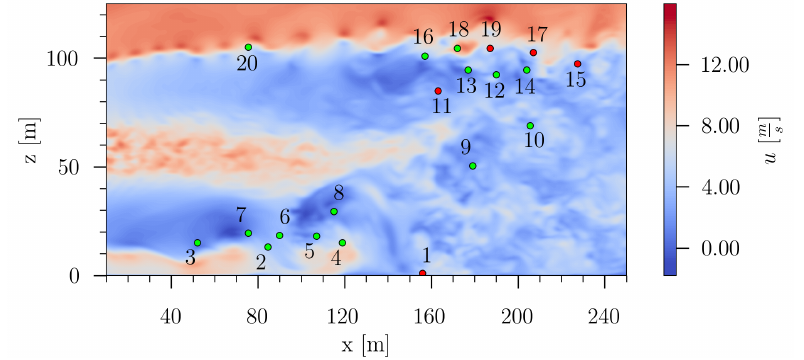
Figure 5. Training sensors (green) and test sensors (red) with snapshot at i t = 0 as